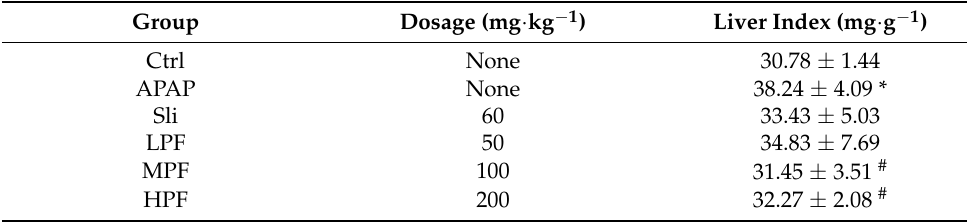
Table 1. Effects of PF on organ indices in liver injury mice caused by APAP (x ± s, n =